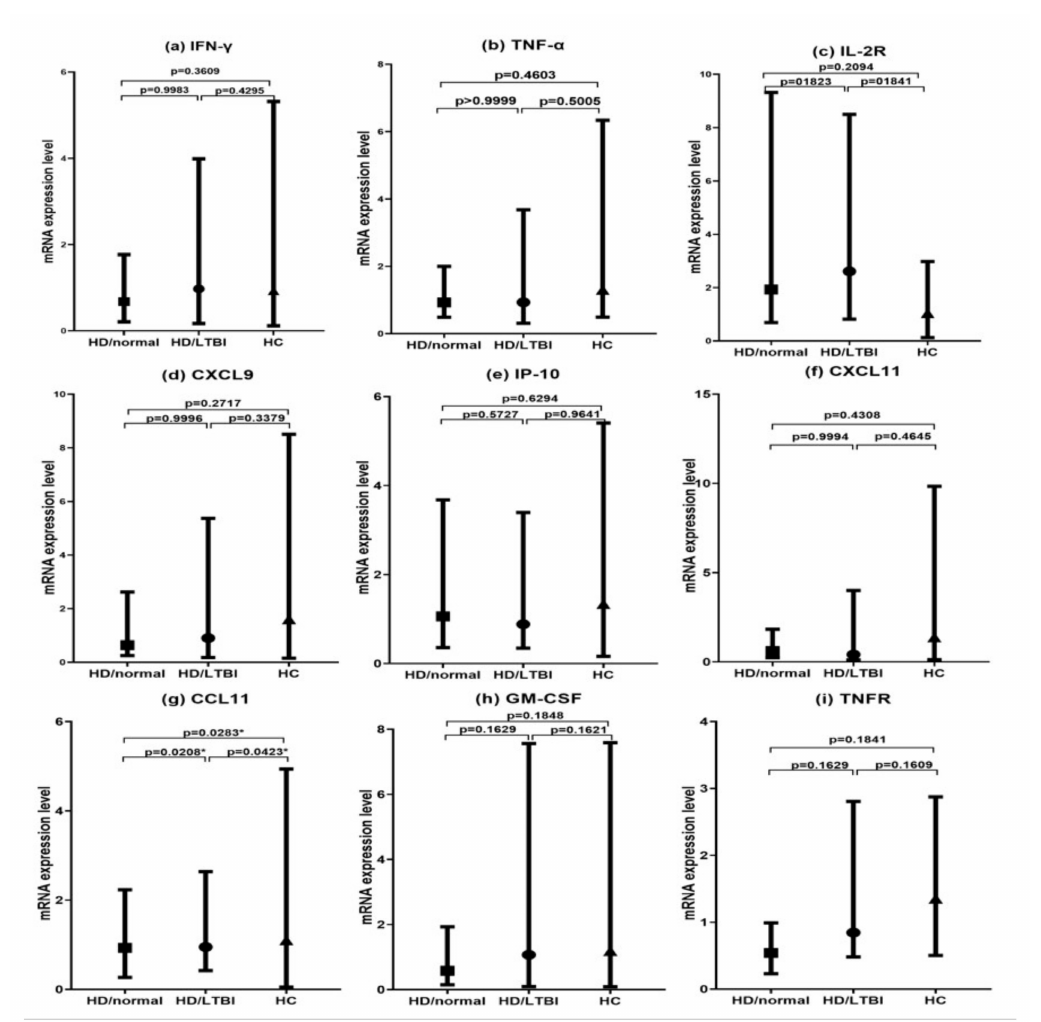
Figure 1. Target gene mRNA expression levels after stimulation of Mycobacterium tuberculosis (MTB)-specific antigens for 24 h according to latent tuberculosis infection (LTBI) diagnosis. Note: Whole blood of study subjects (hemodialyzed patients (HD) without LTBI (HD/normal) groups, HD with LTBI (HD/LTBI) group, and healthy control (HC) group) was stimulated with MTB-specific antigens (early secretory antigen target 6, culture filtrate protein 10, and TB 7.7) for 24 h and the mRNA expression levels for target genes were analyzed using real-time RT-PCR. The graphs represented median ± SD value ( (cid:4) , HD/normal; • , HD/LTBI; (cid:78) , HC) ( a ) interferon (IFN)- γ , ( b ) tumor necrosis factor- α (TNF- α ), ( c ) IL-2R, ( d ) CXCL9, ( e ) IFN- γ -induced protein 10 (IP-10), ( f ) CXCL11, ( g ) CCL11, ( h ) granulocyte-macrophage-colony stimulating factor (GM-CSF), and ( i ) TNF receptor (TNFR). * p <